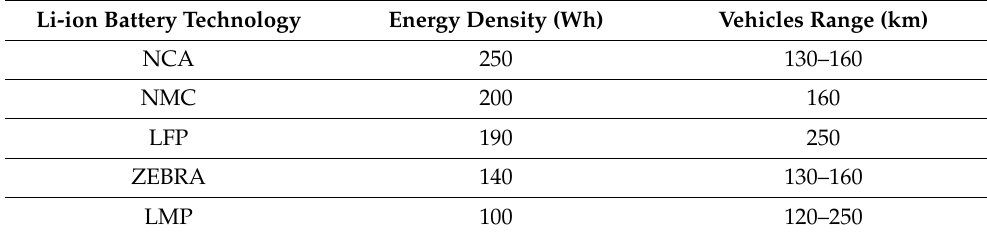
Table 3. Features of battery technologies [13].